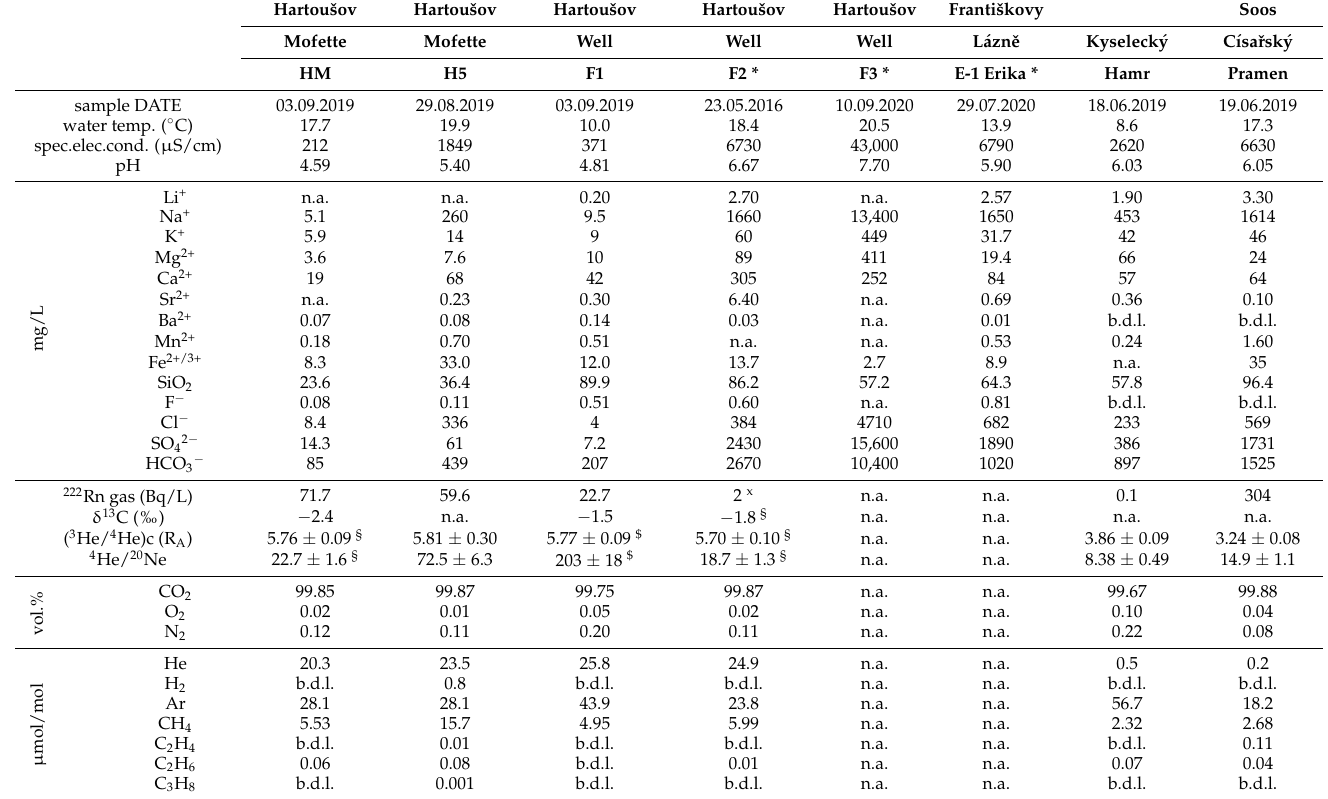
Table 1. Properties of the Hartoušov fluids compared to Františkovy L á znˇe, Kyseleck ý hamr, and Soos C í saˇrsk ý pramen. Chemical and isotopic data of Hartoušov mofette HM, Hartoušov F1, and Hartoušov F2 are taken from Daskalopoulou et al. [22]. The abbreviations n.a. and b.d.l. stand for “not analyzed” and “below detection limit”,